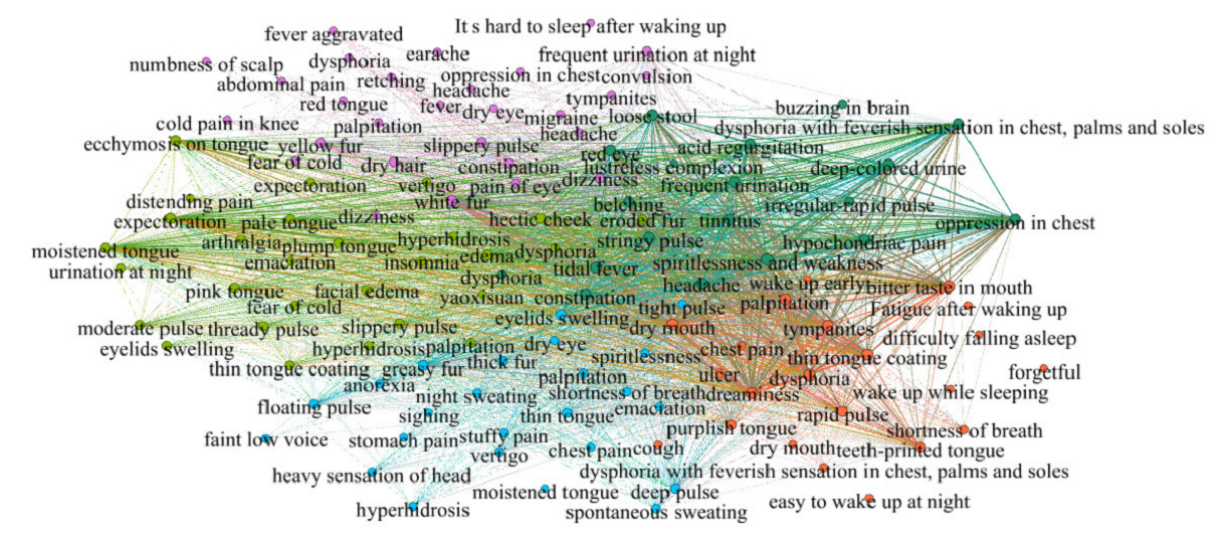
Figure 13. Symptom communities (d=164 and